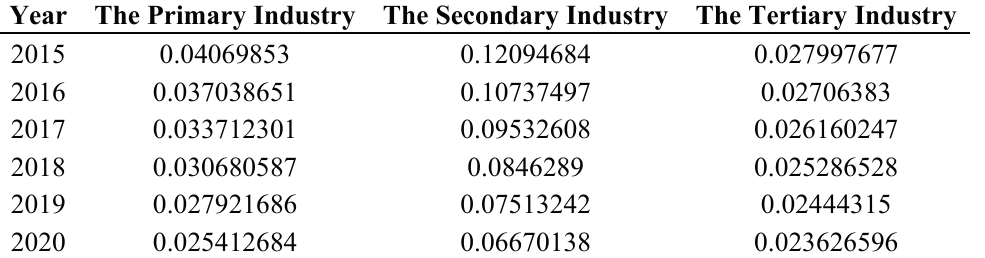
Table 8. Predicted values of the power needed in 100 million yuan (100 million kilowatt-hours).